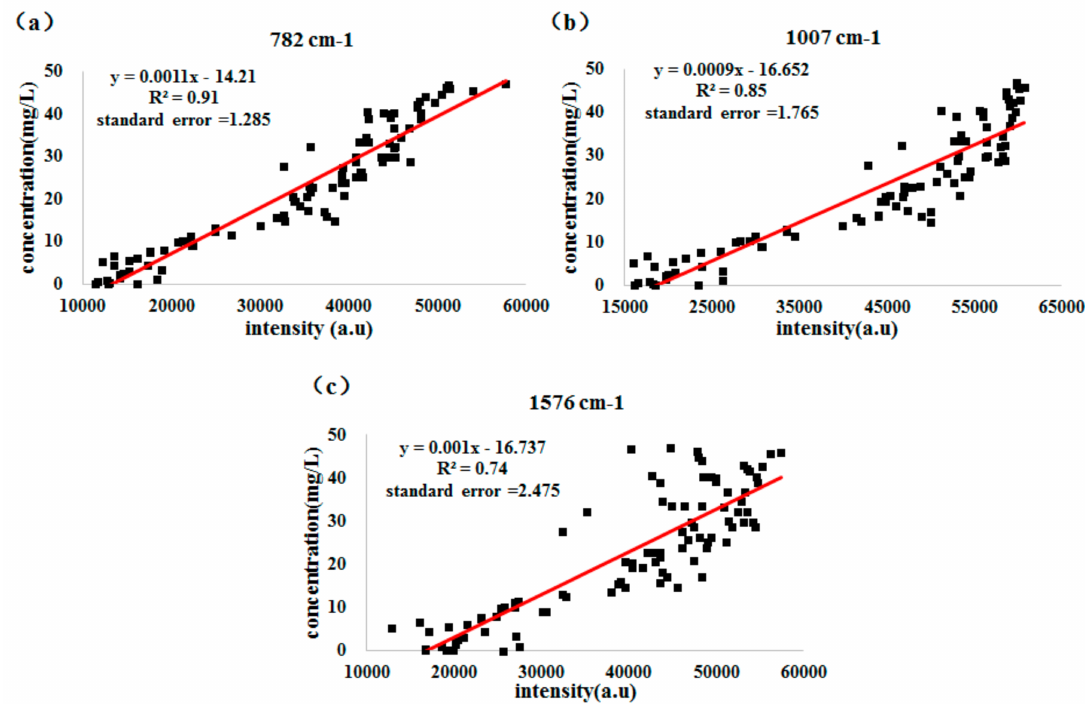
Figure 9. Regression equation of different characteristic band and SERS peak intensity. ( a ) Regression equation at 782 cm − 1 ; ( b ) Regression equation at 1007 cm − 1 ; ( c ) Regression equation at 1576 cm − 1 .